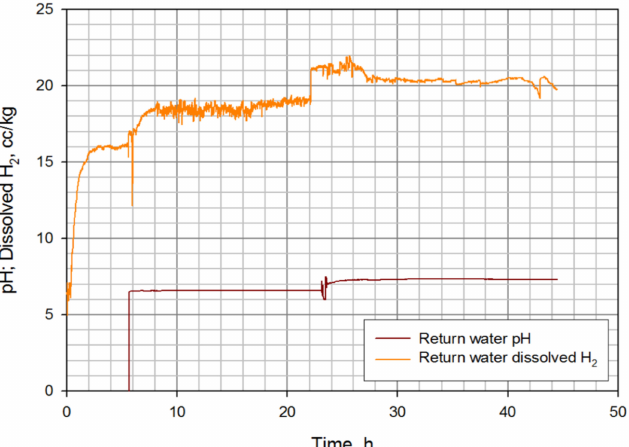
Figure 9. pH and dissolved hydrogen during the first operational test of the recirculation loop. Hydrogen content was increased when the temperature was increased from ~200 to 300 and again from 300 to 340 ◦ C. pH sensor was initiated ~5.5 h after the cycle began.